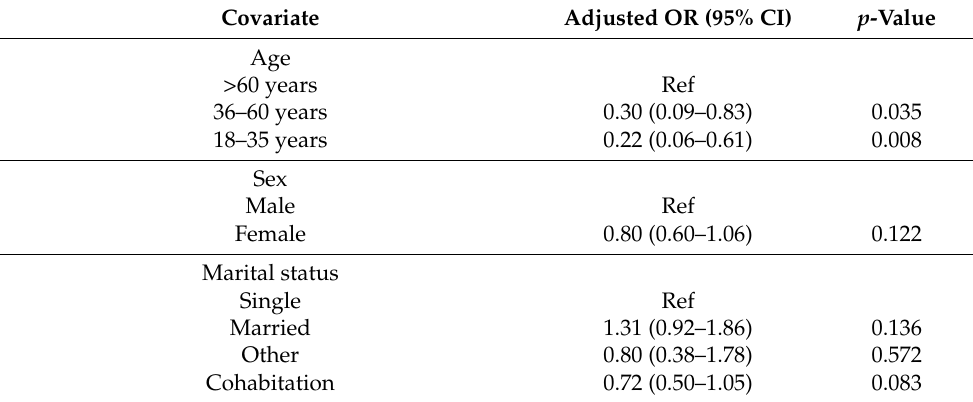
Table 4. Multiple logistic regression model investigating predictors for COVID-19 vaccine acceptabil-